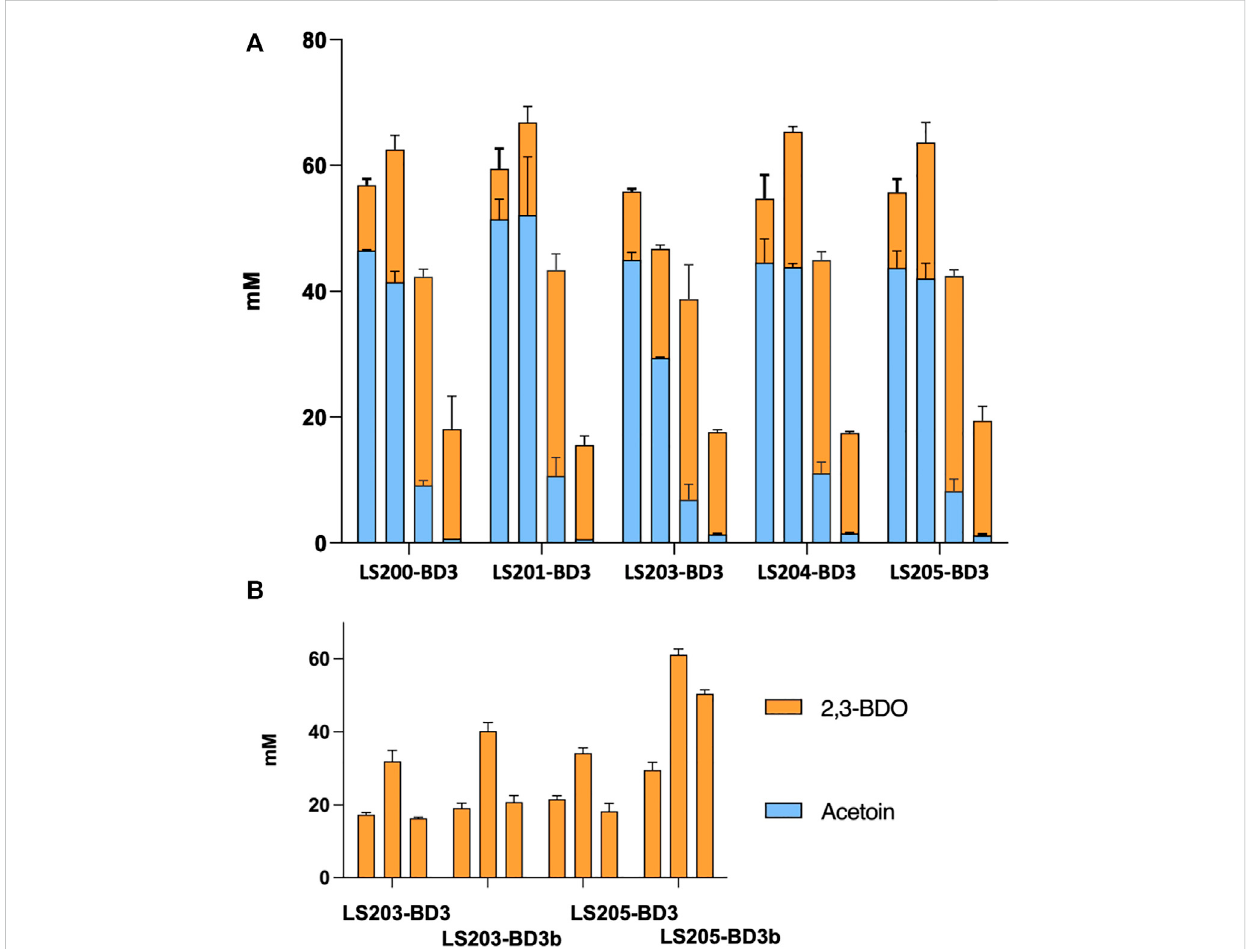
The effect of aeration and BDH overexpression on yields of acetoin and 2,3-BDO. (A) Combined acetoin and 2,3-BDO concentrations in Δ adhE strains(LS200-LS205)habouringplasmidpMTL-BD3underdifferentaerationconditions.ThemediaemployedwasM-ASYEmediumcontaining2%(w/v) yeast extract and glucose. All fermentations were undertaken at 50 ° C for 48 h and in 50 mL falcon tubes with shaking (250 rpm). High to low aeration conditions were imposed by the use of either 2 mL, 3 mL, 5 mL or 10 mL culture volumes, represented by column 1 – 4, left to right. Increasing aeration increases carbon fl ux to the acetone/2,3-BDO pathway. Concentrations are calculated as an average of three biological replicates. (B) 2,3-BDO concentrationsinstrainLS203andLS205with(pMTL-BD3)andwithout(pMTL-BD3b)overexpressionofthenative bdh .Overexpressionof bdh